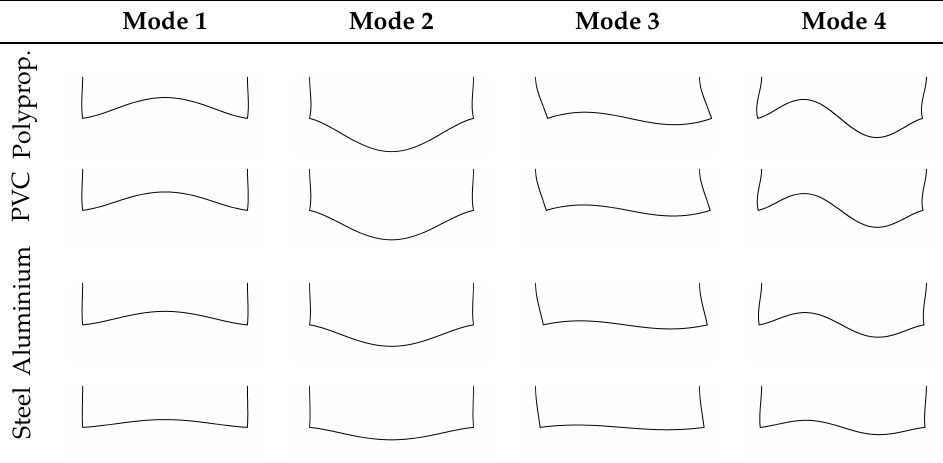
Table 11. Computed shapes of first four modes for different